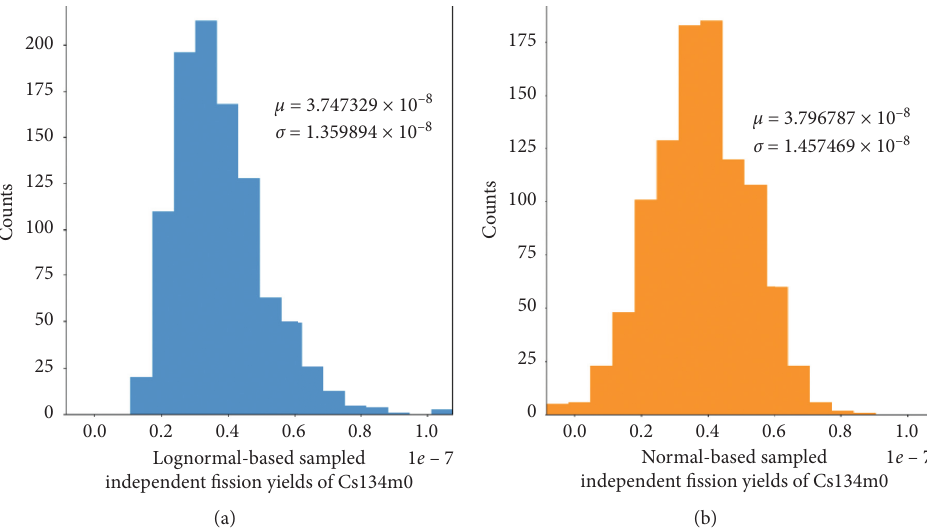
Figure 15: Histogram comparison of lognormal sampled (a) and normal sampled (b) independent fission yields of Cs134m0. This fission product has relative uncertainty of 38.4%. The text presents the sampled mean value and STD and the population mean and STD for Cs134m0 are 3 . 8544056 × 10 − 8 and 1 . 456322 × 10 − 8